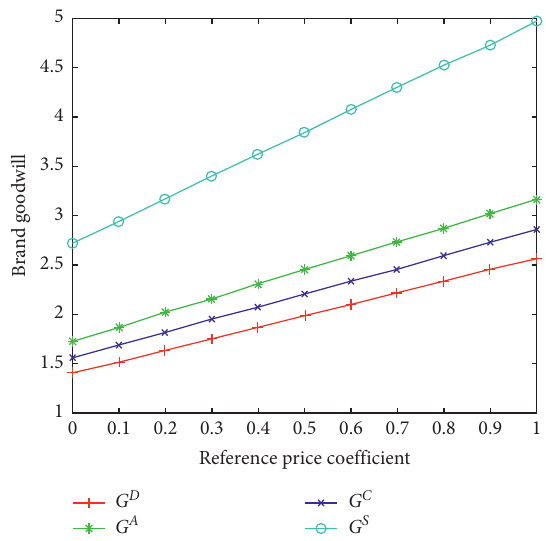
Figure 3: The impact of consumer reference effect on brand